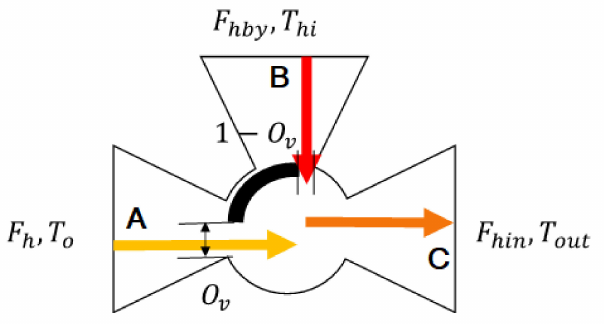
Figure 6. 3-way valve (installed downstream).